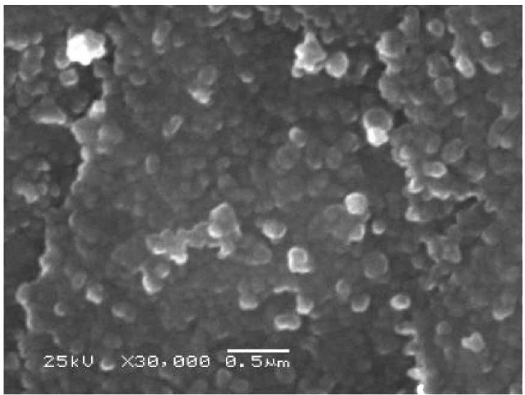
FIGURE 2 SEM micrograph of a TiO 2 thin film obtained by drying a drop of the colloidal solution on a glass